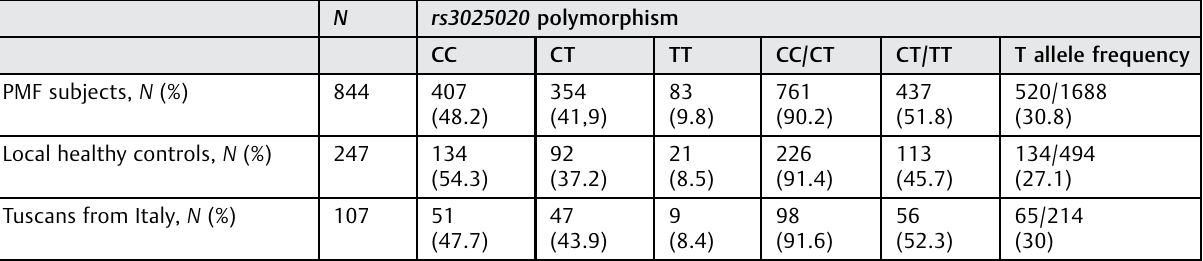
Table 2 Genotype and allele frequencies of the rs3025020 polymorphism of VEGFA in 844 patients with primary myelo fi brosis (PMF), 247 subjects of healthy control population, and 107 subjects reported from “ Tuscan from Italy